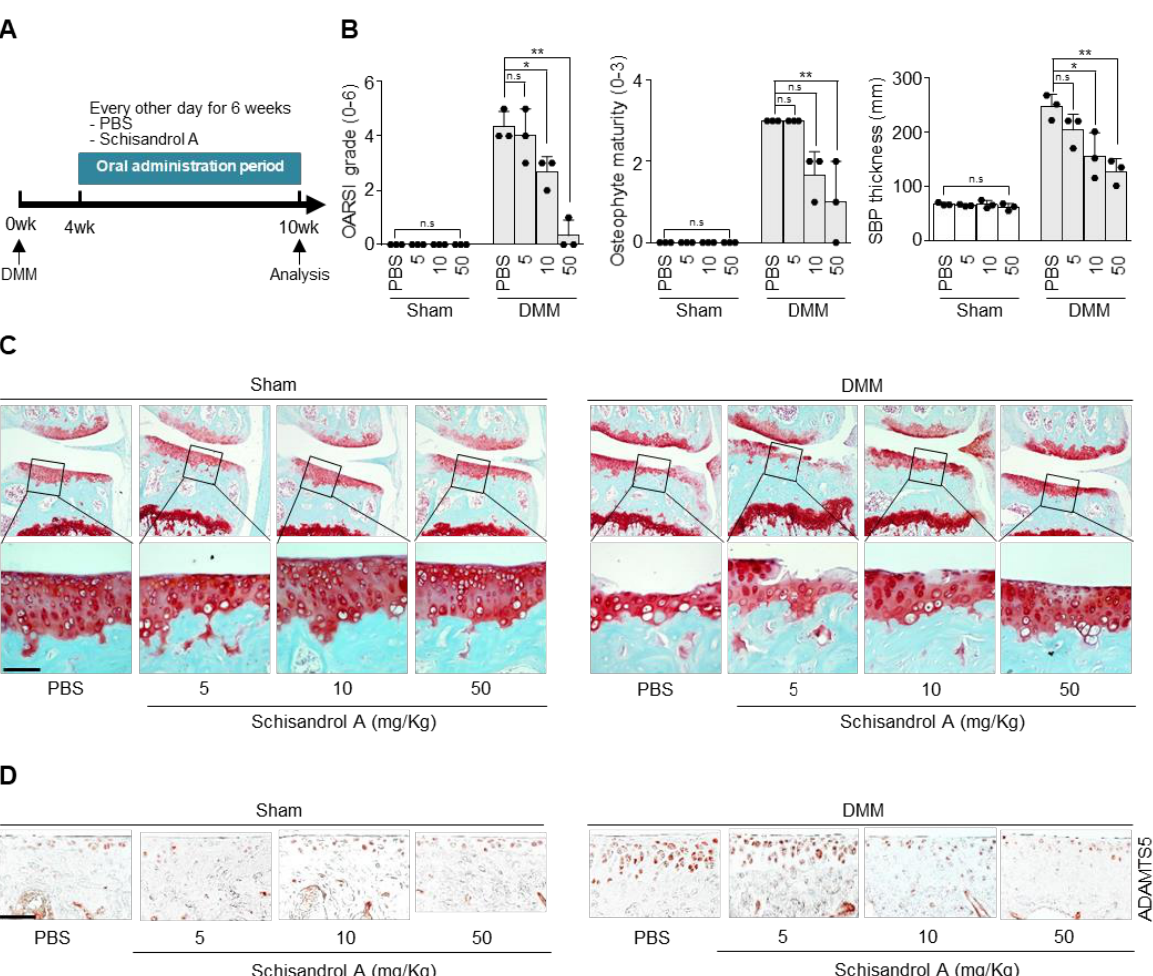
Figure 3. Oral administration of Schisandrol A protects against cartilage degradation in osteoarthritis (OA). ( A ) Overall experimental plan for the analysis of the DMM-induced OA model ( n = 3 for each group). Mice were administered PBS or Schisandrol A (5, 10, or 50 mg/kg) every other day from 4 weeks after DMM surgery until they were analyzed at 10 weeks. ( B ) Cartilage degradation was determined by Osteoarthritis Research Association International (OARSI) score, osteophyte maturity, and subchondral bone plate thickness (SBP) at 10 weeks after DMM surgery. Data were analyzed using one-way ANOVA with Bonferroni’s test, and plotted values were expressed as means ± SEM; n.s. p > 0.05, * p < 0.05 and ** p < 0.01 compared to the control (PBS) group. ( C ) Analysis of cartilage degradation was performed by safranin O staining. ( D ) Expression of ADAMTS5 in cartilage of DMM-induced OA model is determined with immunostaining. Scale bar = 100 μm.